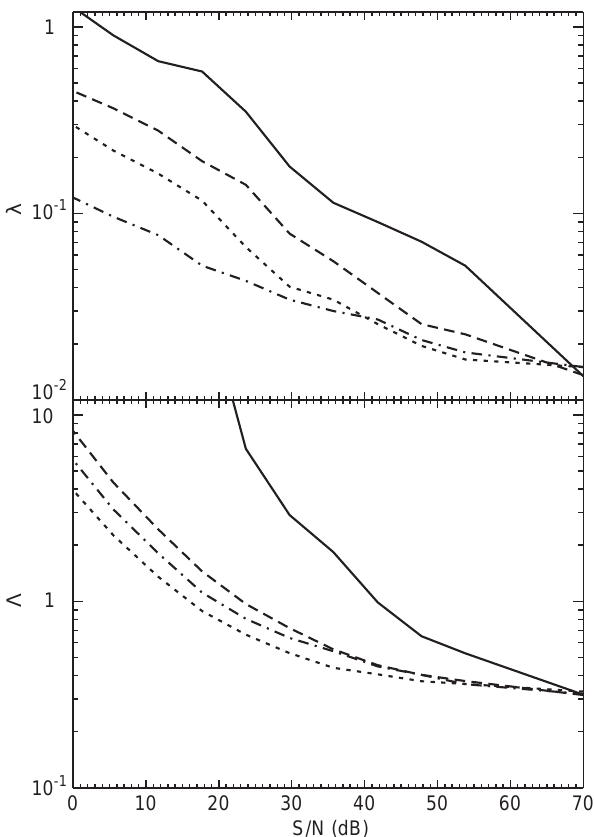
Fig. 4. Quality and reconstruction parameters for an increasing signal- to-noise ratio in the original images and after application of di(cid:128)erent filters in the modified MART algorithm. The solid line represents MART without any filter, the dashed line MART with nonnegative constraint, the dotted line MART with median filter, and the dash- dotted line MART with Fourier